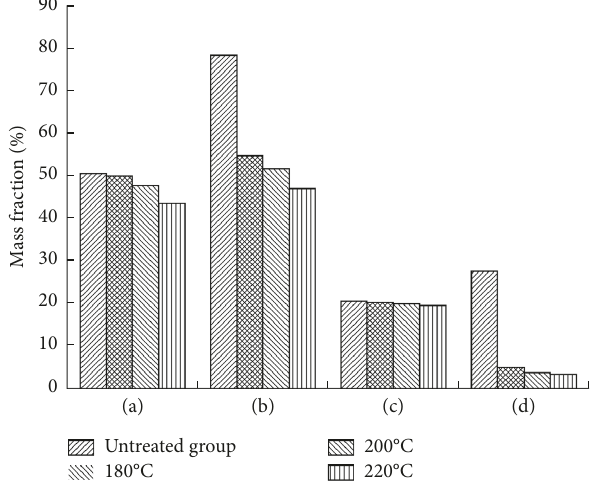
Figure 3: The changes in the contents of the nutrients in the specimens that had initial 5% MC and were treated at various temperatures: (a) cellulose, (b) holocellulose, (c) lignin, and (d) hemicellulose. Table 3: Contents of the nutrients in untreated and heat-treated specimens. Initial MC/heating temperatures